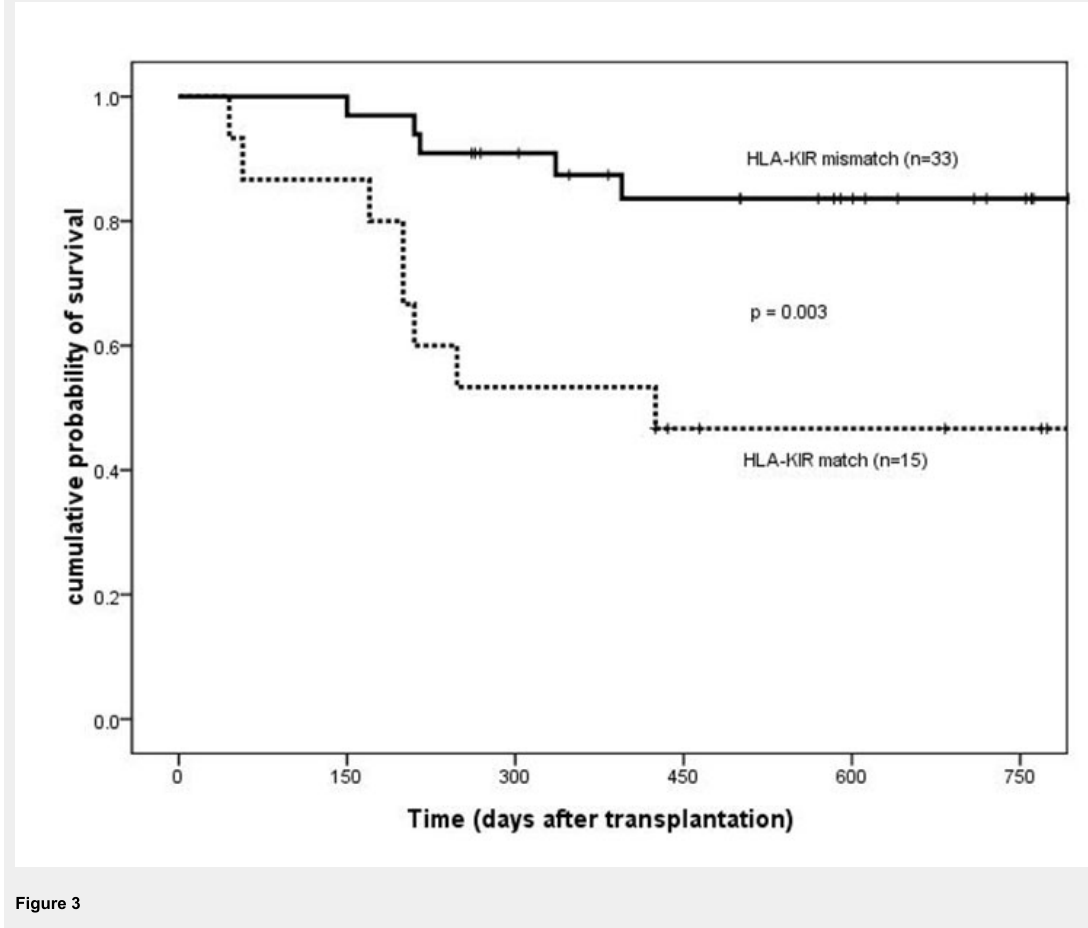
Figure 3 Overall survival of patients based on HLA-KIR match/mismatch group. HLA = human leukocyte antigen; KIR = killer immunoglobulin-like